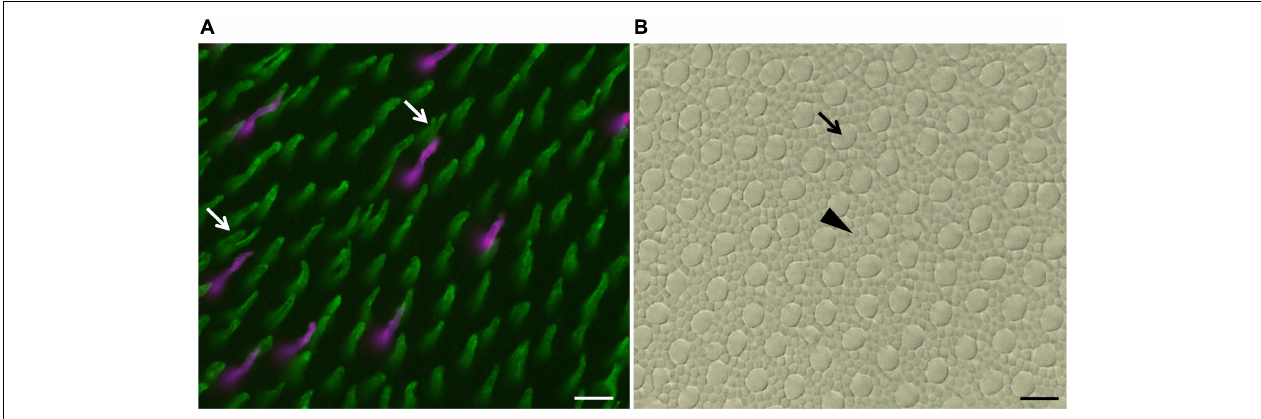
FIGURE 2 | Images of a counting field of a whole-mounted retina of B. jararaca double-labeled with anti-SWS1 opsin and anti-LWS opsin antibodies. (A) Outer segments of LWS cones (green), including single cones and double cones (white arrows), and of SWS1 cones (magenta). (B) Mosaic of photoreceptors of the same field shown in (A) , viewed under bright light: inner segments of rods (black arrowhead) and cones (black arrow). Scale bars 10 µ m.